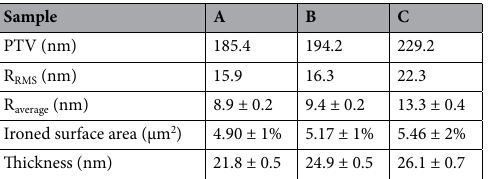
Table 2. Multilayer thickness and surface roughness parameters for CAR/CS films with (sample A and B) and without nisin Z (sample